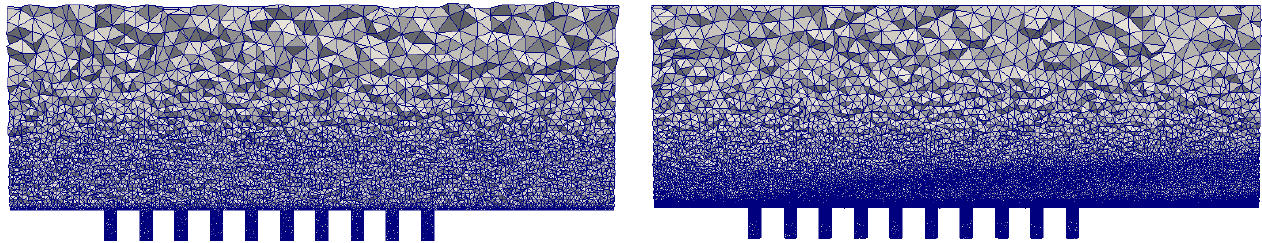
Figure 4. Comparison of original mesh ( left ) and adapted mesh ( right ) on a cut along the symmetry plane of the domain, focus on the perforated